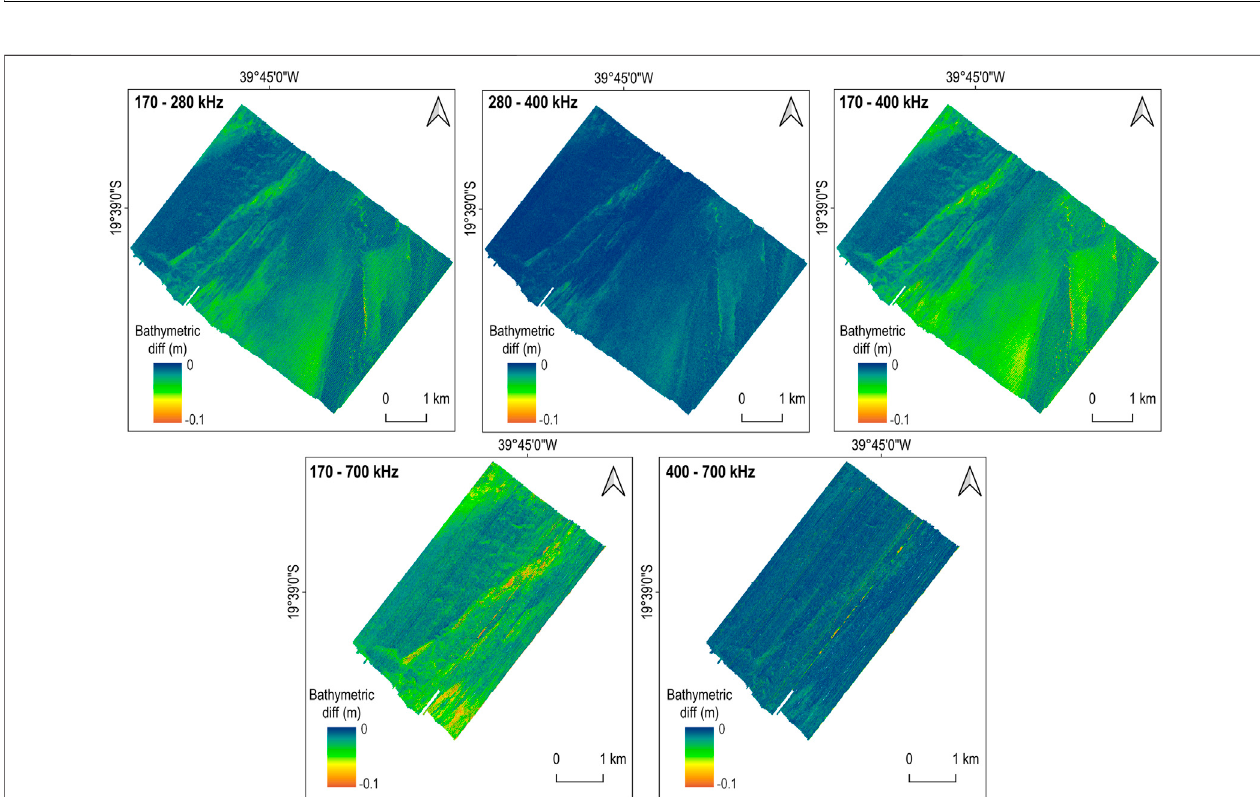
FIGURE 5 | Bathymetric difference surfaces (in meters) computed from the subtraction between the digital bathymetric models of each frequency.